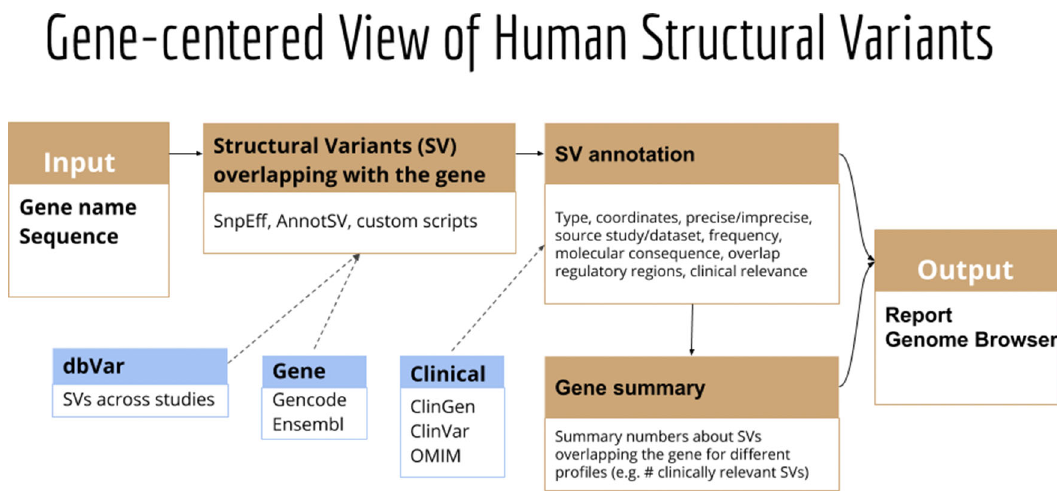
Figure 8. Methodology used by GeneVar for the production of summary report made available through genome browser. A graphical representation of the pipeline used by GeneVar in order to provide clinicians with a comprehensive summary of SVs associated with a user provided gene